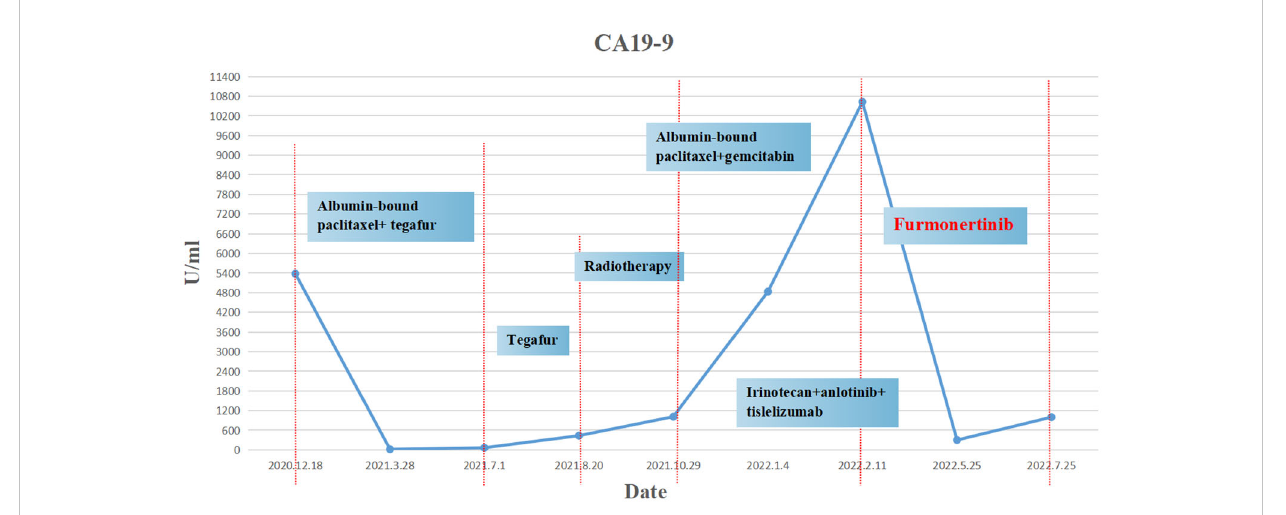
FIGURE 2 CA19-9 changes throughout the